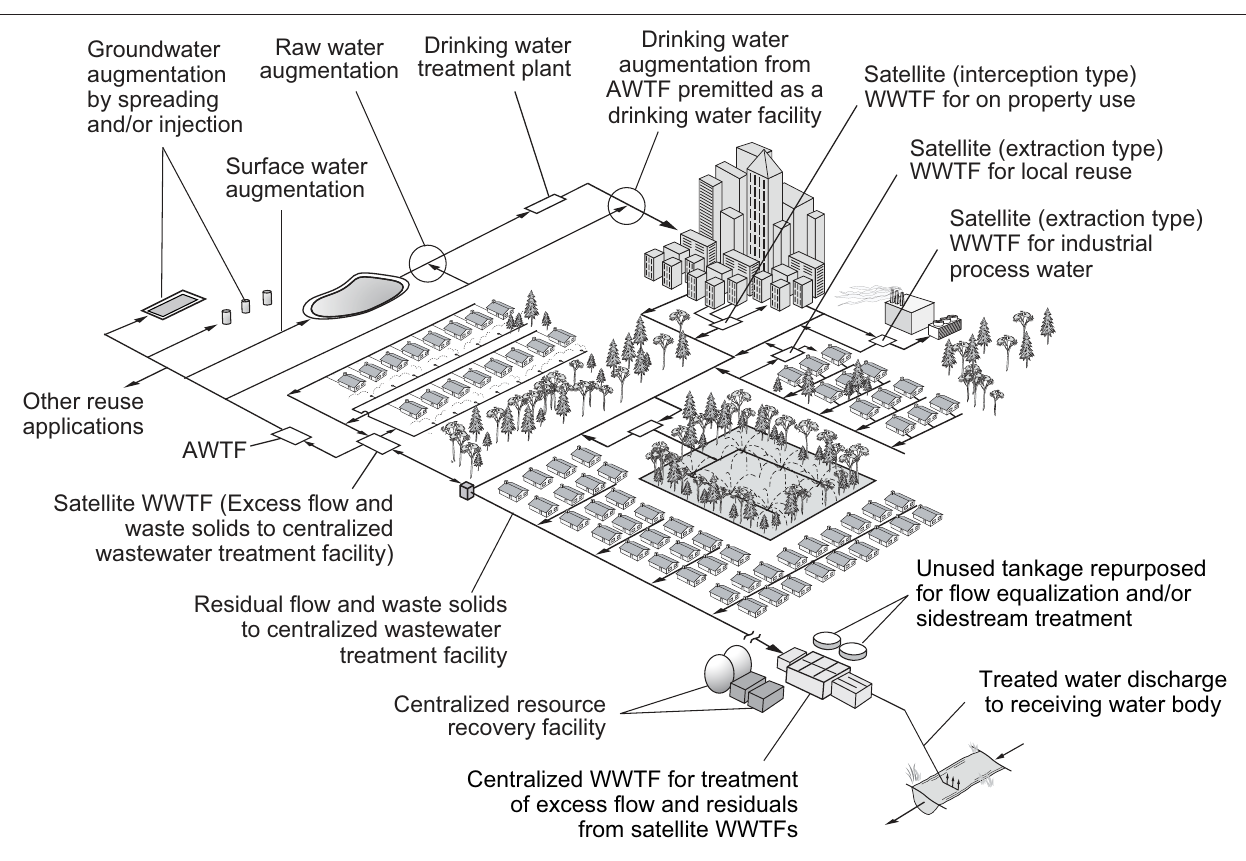
at a constant flowrate, their performance can be optimized, producing a higher quality effluent with less variability for both non-potable and potable reuse